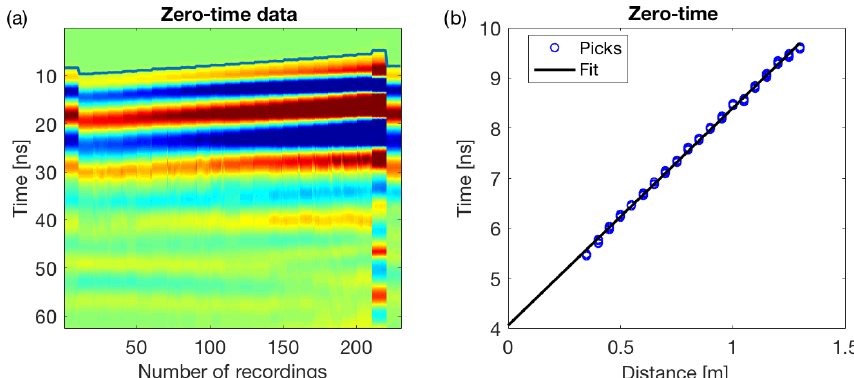
Figure A1. (a) Data collected in 2016 for zero-time correction showing 10 recordings per distance as well as the first arrival picks. (b) Picked first arrivals vs. distance with the corresponding linear regression fit. First and last 10 stacks are not